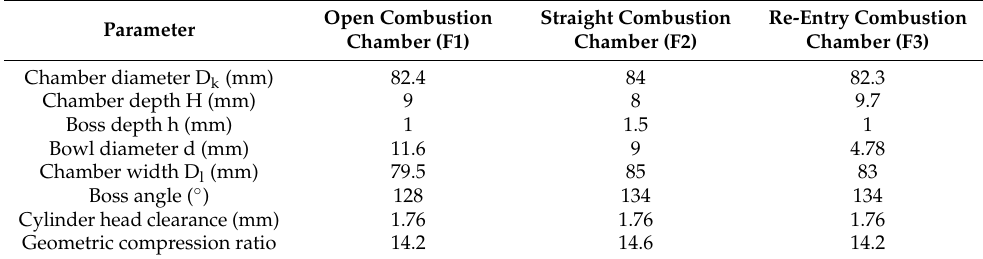
Figure 1. Geometric parameters of the combustion chamber. Table 1. Comparison of the geometric parameters of combustion chambers.